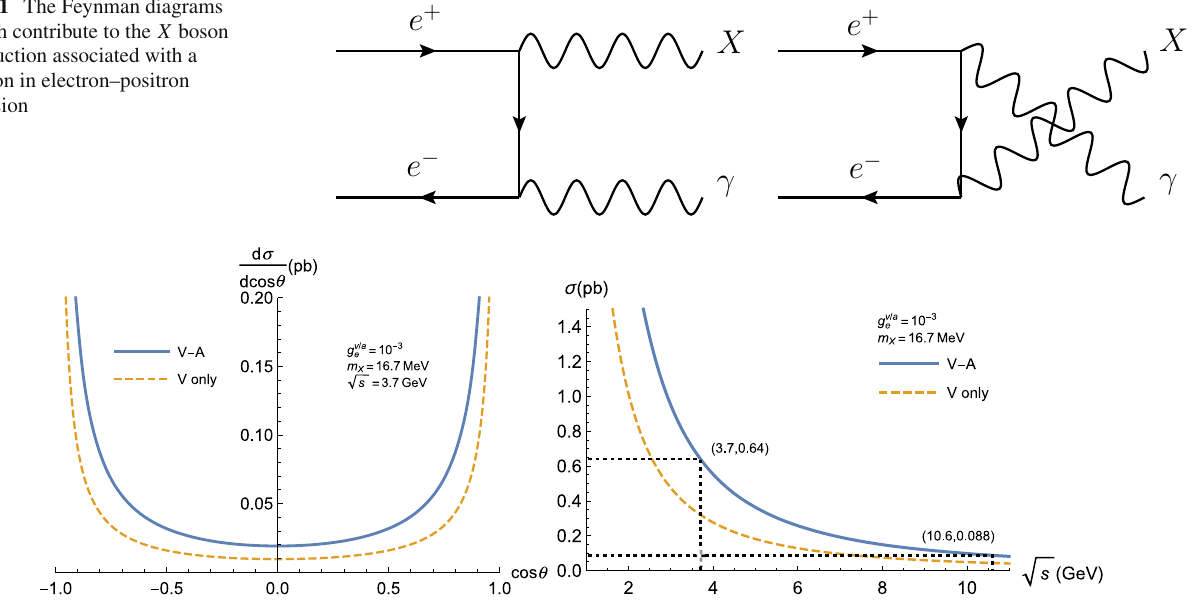
√ s . The legend “V-A”